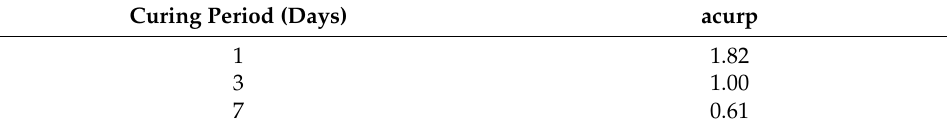
Table 26. Curing parameter acurp [54].